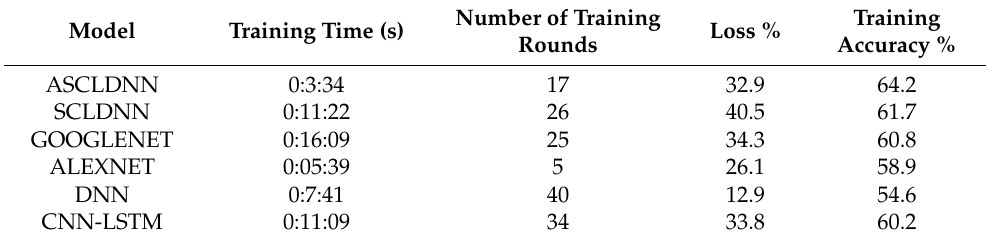
Table 3. Training classification effect of various models.